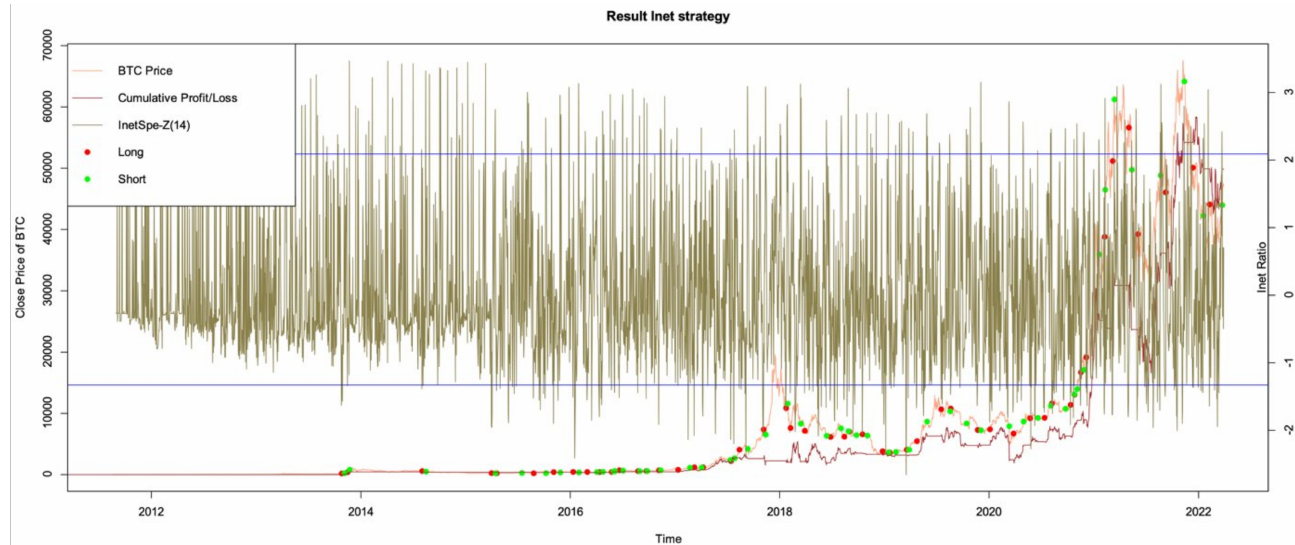
Figure A6. InetSpe-Z strategy: BTC price (orange line, left-hand side), cumulative profit/loss (red line, left-hand side), InetSpe-Z ratio (brown line, right-hand side), long and short thresholds (blue lines, right-hand side), long orders (red points), and short orders (green